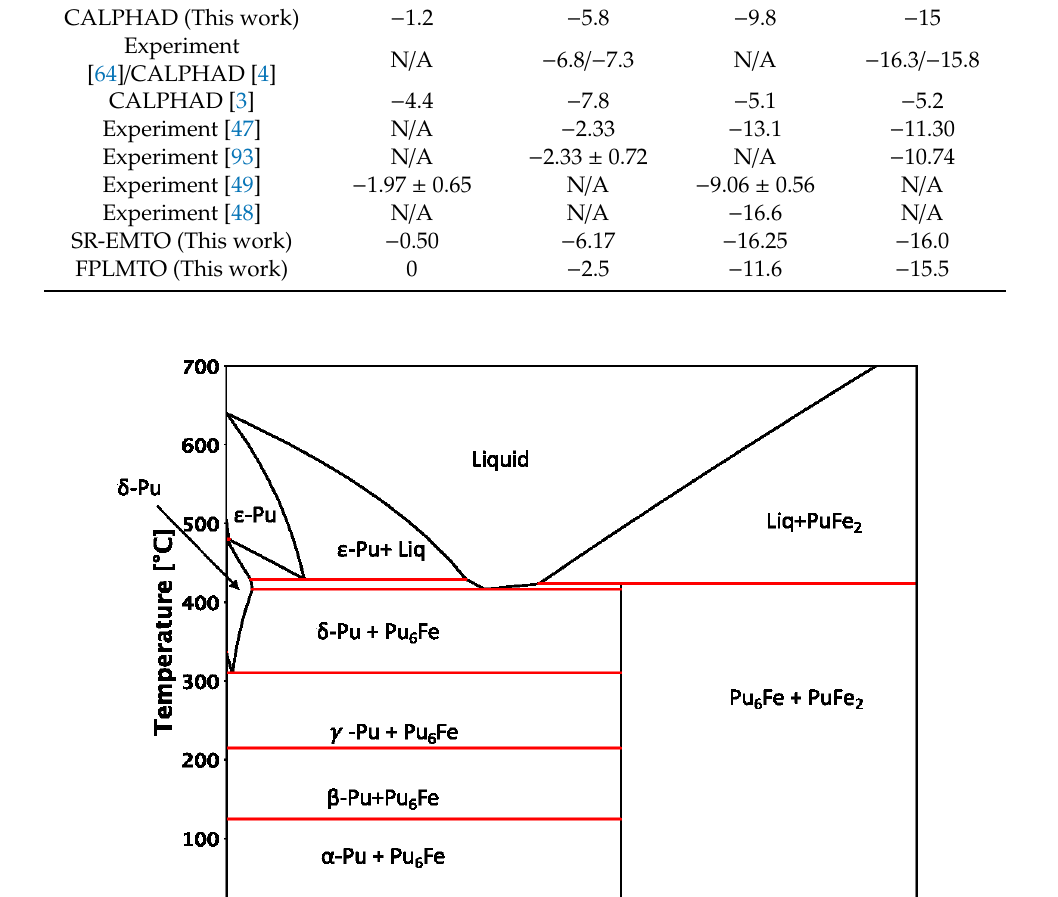
Table 6. ∆ f H (kJ / mol) of Pu-Fe and U-Fe compounds compared to DFT calculations and experiment. Method / Refs.